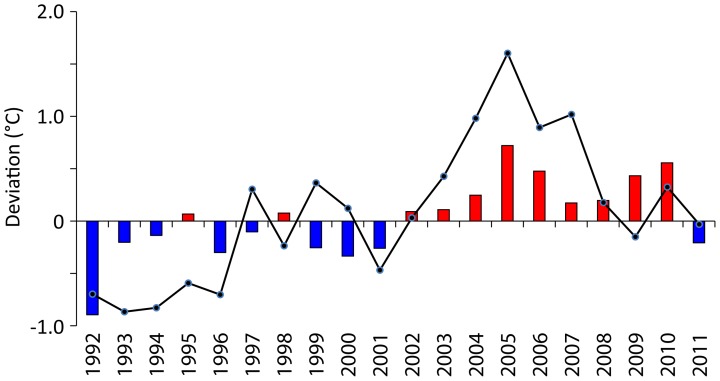
Air (line) and surface water temperature (bars) anomalies for Lake Nkuruba over 20 years.Anomaly computed as the difference from the 1992–2011 mean air and surface water temperatures.